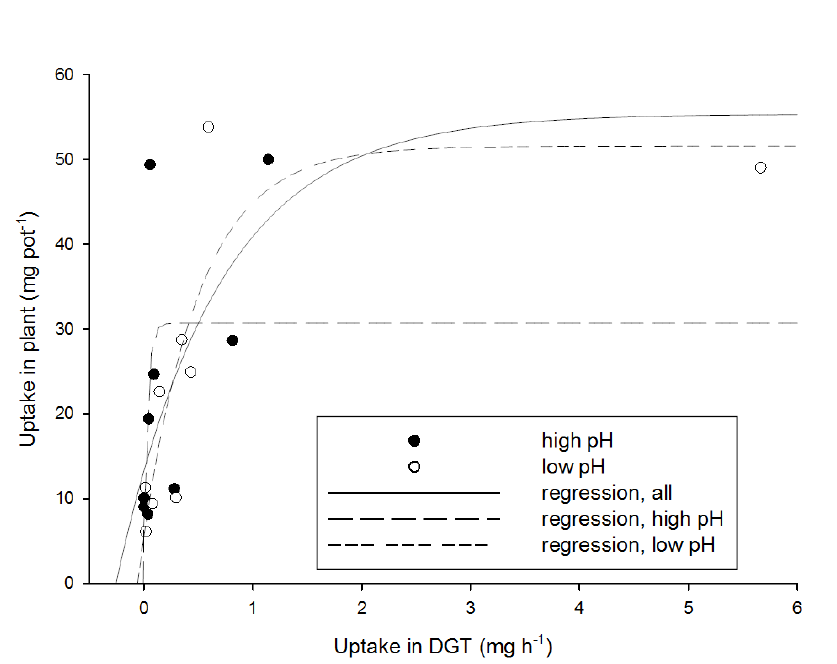
Fig. 4. Uptake in the plant as a function of uptake in DGT in the soil before plant growth. Points are averages (n=3), filled circles show high pH treatments, open circles show low pH treatments. Regression lines for all treatments (solid line) and for each pH treatment separately (dotted lines) are